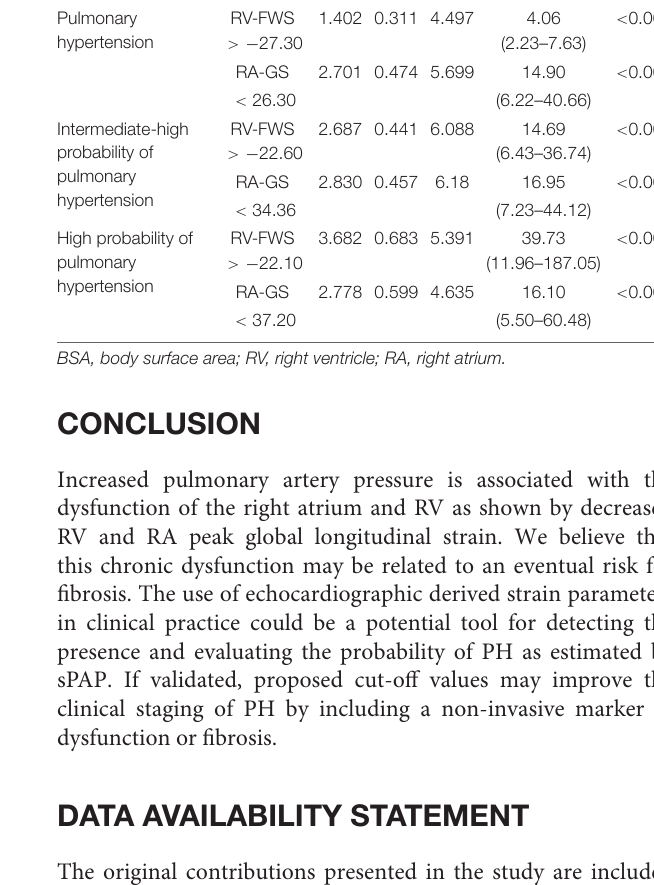
TABLE 3 | A logistic regression model to predict intermediate/high PH using identified cut-off values for each outcome adjusted for sex, age, and BSA.